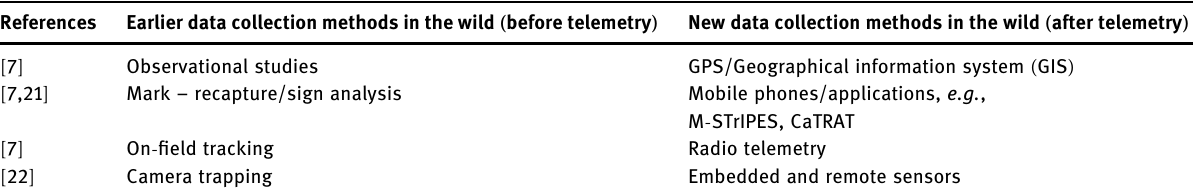
Table 4: Earlier and new data collection methods in wildlife